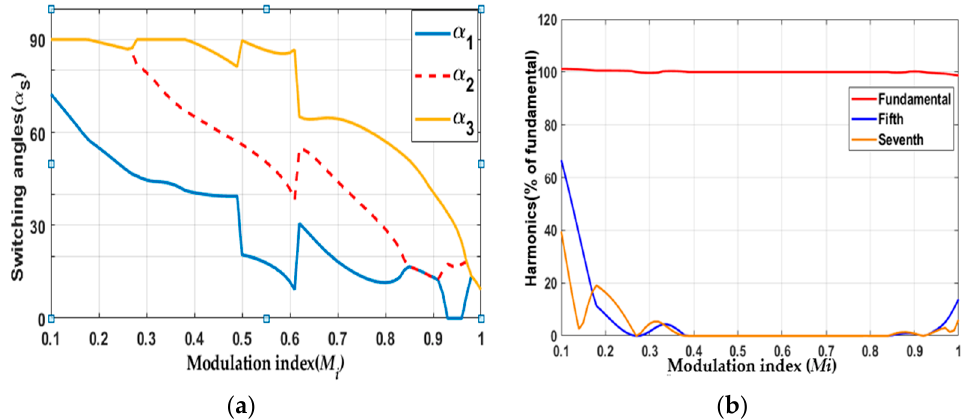
Figure 10. ( a ) Switching angles versus modulation index. ( b ) Harmonics order of fifth and seventh in % of fundamental versus modulation index.